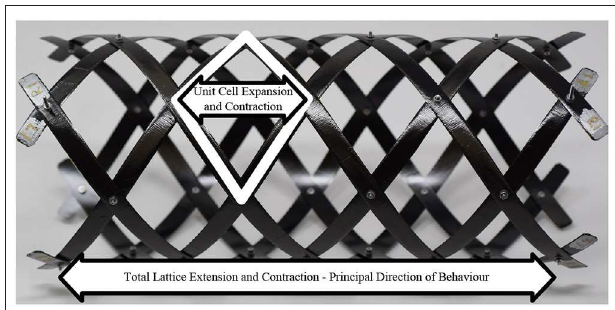
FIGURE 1 | Prototype of a helical lattice structure that behaves as a one-dimensional non-linear spring. Figure reproduced from O’Donnell et al.